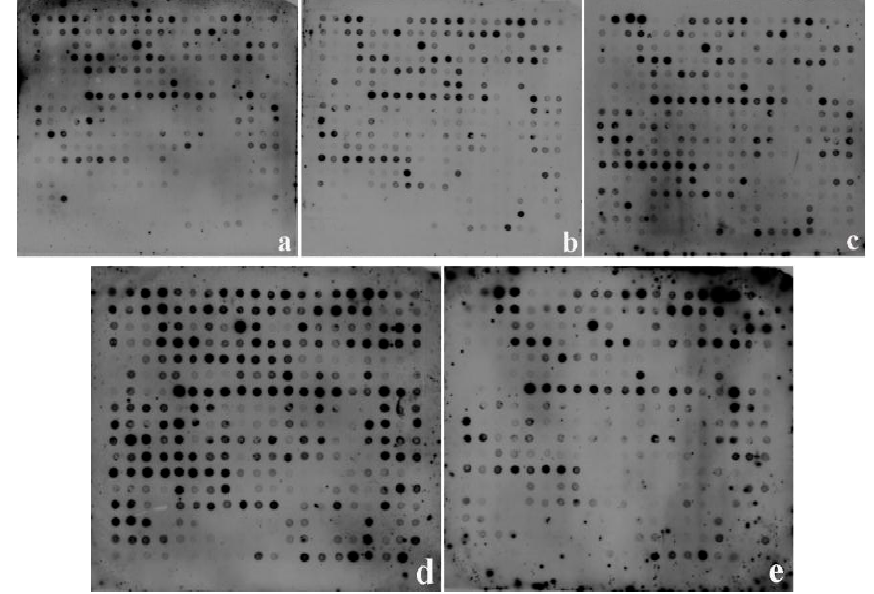
Figure 3. Reverse Northern dot blot analysis of differentially expressed genes. Cloned cDNAs were amplified, denatured, and blotted on five nylon membranes as described. Membranes were hybridized with DIG-labeled total cDNAs from control. ( a ) 0 hpi; ( b ) 12 hpi; ( c ) 24 hpi; ( d ) 72 hpi; ( e ) 120 hpi.